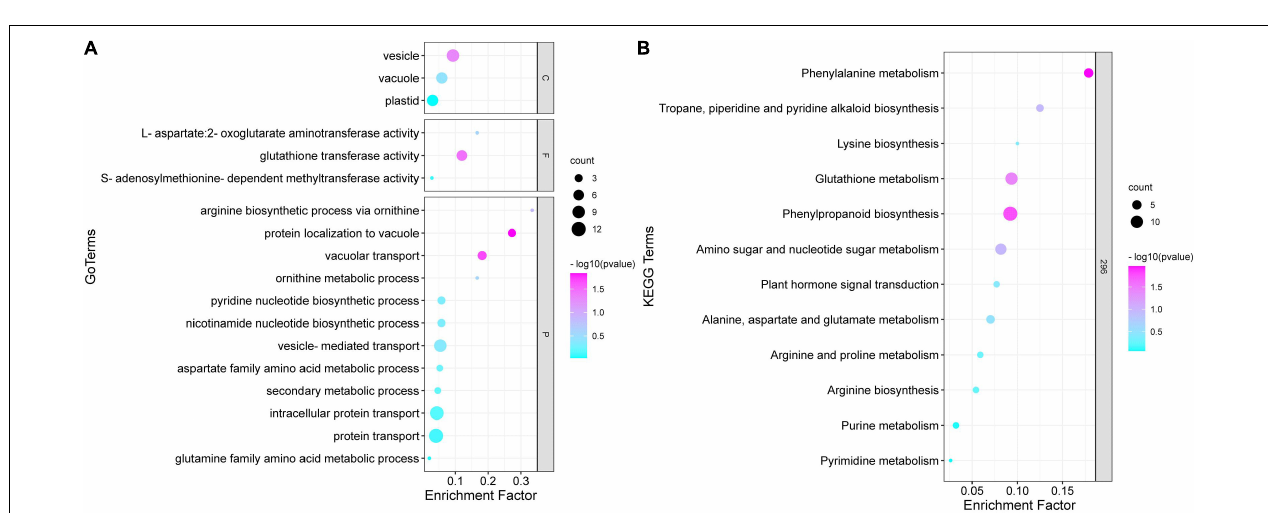
and the whole process is also involved in synthases and transporters (Dewey and Xie, 2013). Moreover, the related intermediate metabolites are jointly controlled by adjacent